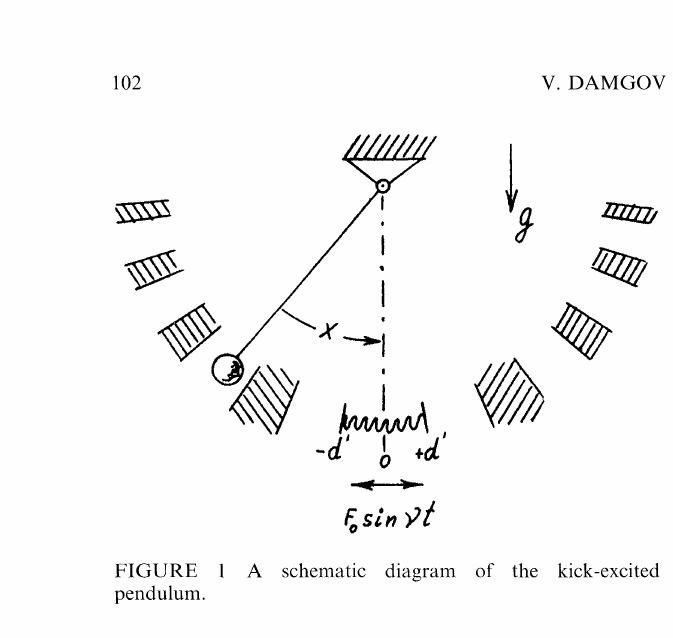
FIGURE A schematic diagram of the kick-excited